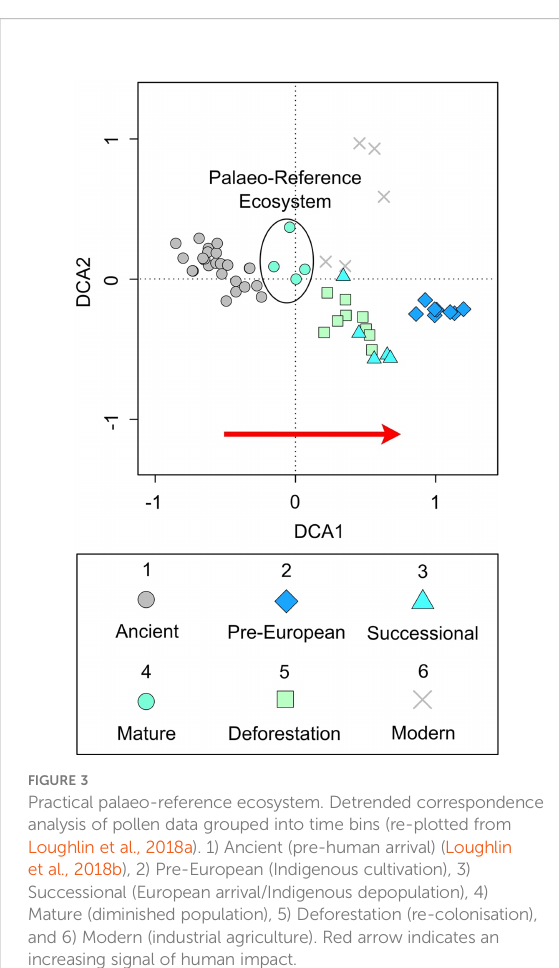
FIGURE 4 Summary diagram of Ecuadorian montane forest succession driven by changes in land use. (A) pre-CE 1588 Indigenous agriculture, (B) CE 1588-1718 European arrival and Indigenous depopulation leading to secondary forest growth, (C) CE 1718-1819 a diminished population and establishment of mature forest, and (D) post-CE 1819 re-colonisation of the landscape and modern